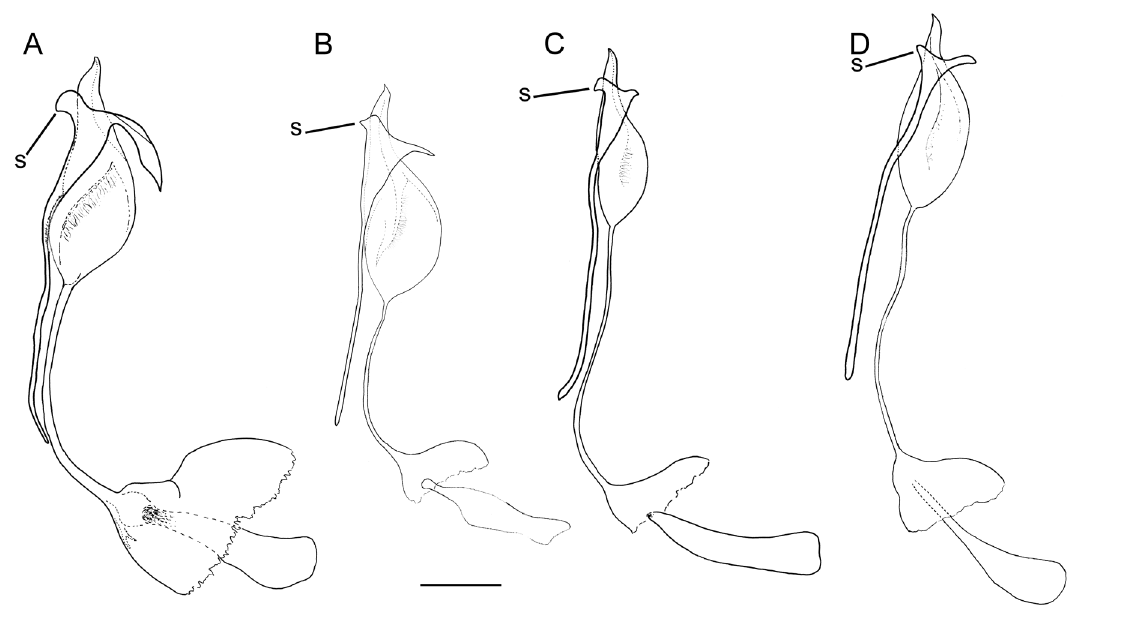
Fig. 18. Male genitalia, aedeagus, lateral view. A. Merodon lotus Vujić & Radenković sp. nov., paratype (FSUNS; FSUNS ID ZA6_060). B . M. multifasciatus Curran, 1939 (NBCN LML-05-3; FSUNS ID 03909). C . M. vittatus Vujić & Likov sp. nov., holotype (NBCN; FSUNS ID 04085). D . M. nasicus Bezzi, 1915 (TAUI; FSUNS ID 04972). Abbreviation: s = lateral sclerite of aedeagus. Scale bar = 0.25